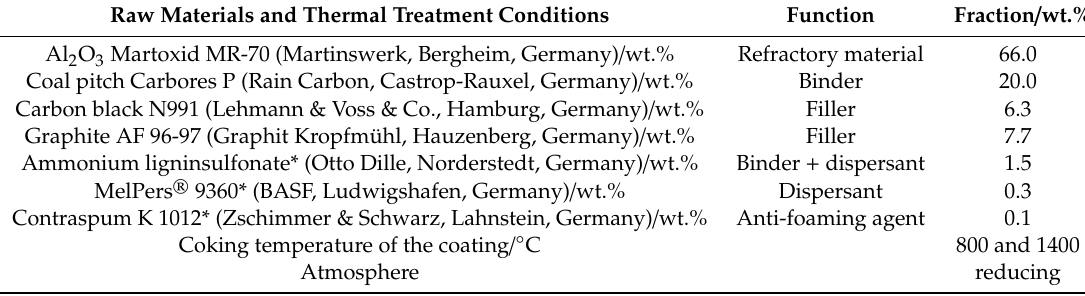
Table 2. Composition and thermal treatment conditions for the preparation of Al 2 O 3 -C coating. (* based on sum of